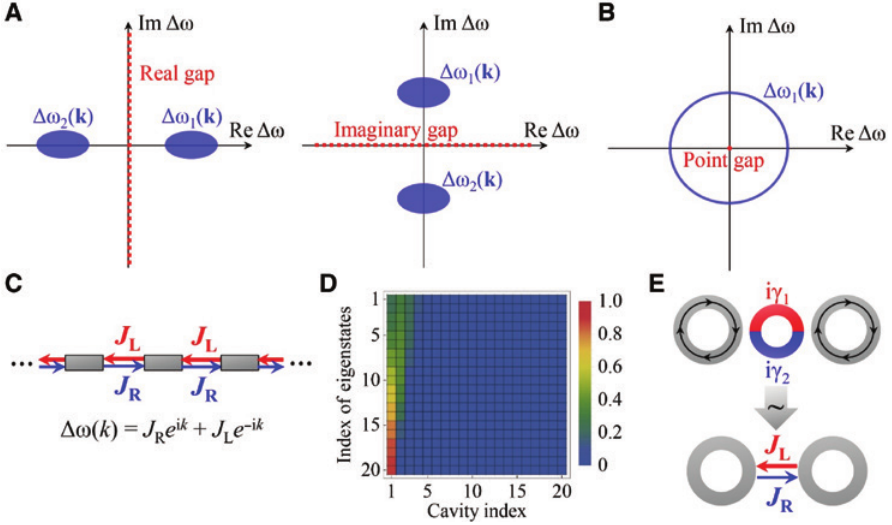
Figure 11: Complex bandgaps and non-Hermitian skin